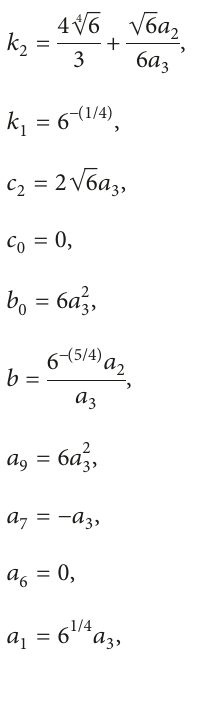
t 20, (b) t 0, and (c) t 60. The contour (cid:28) − (cid:28) (cid:28)